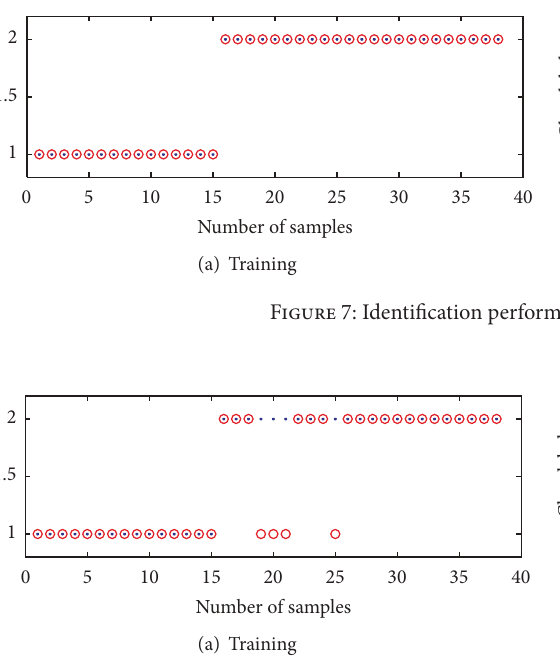
Figure 8: Identification performance of the SIMCA classifier.